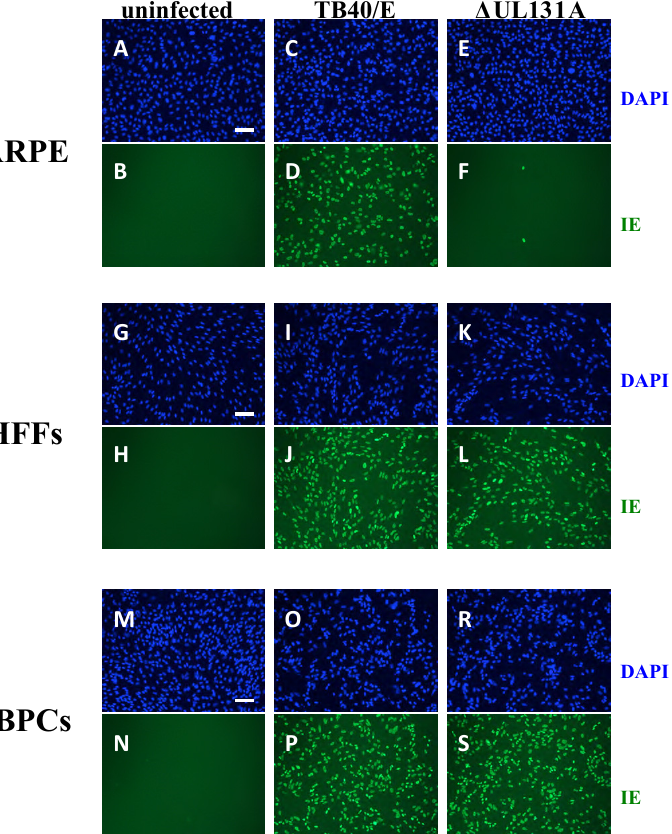
Figure 4. HCMV pentamer complex is dispensable for virion entry into TBPCs. ARPE-19 cells ( A – F ), HFFs ( G – L ) and TBPCs ( M – S ) were mock infected or infected (MOI 2) with parental TB40/E and UL131A-deficient mutant ( Δ UL131A) and immunostained for